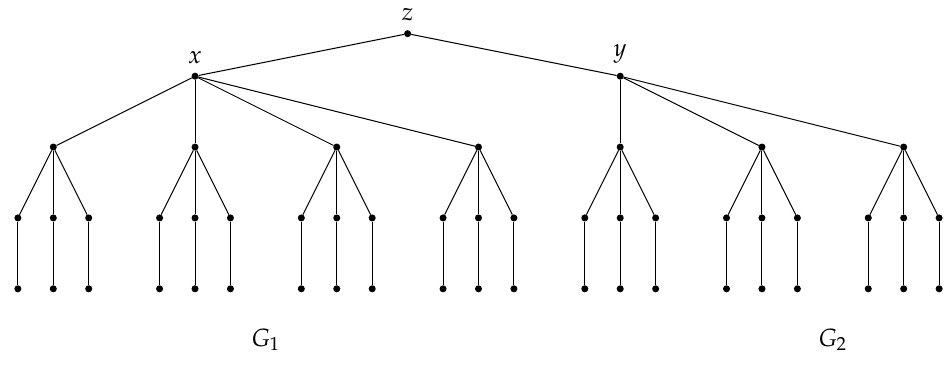
Figure 1. The graph G t + xz for t =